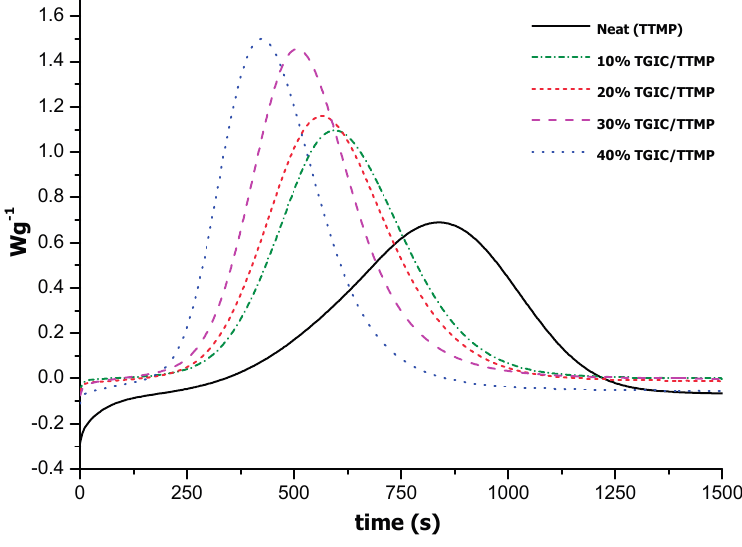
Figure 2. DSC thermograms of the isothermal curing at 100 °C of the mixtures with TTMP and different proportions of TGIC catalyzed by 0.5 phr of